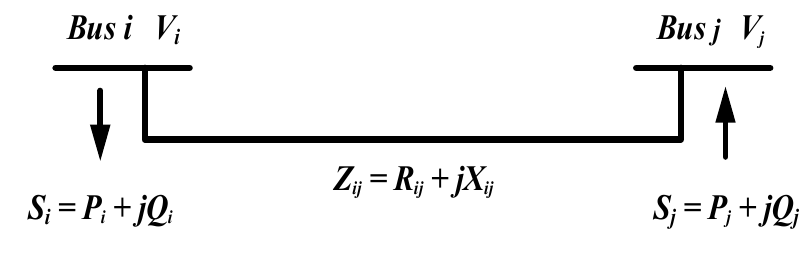
Figure 1. Two bus power system.